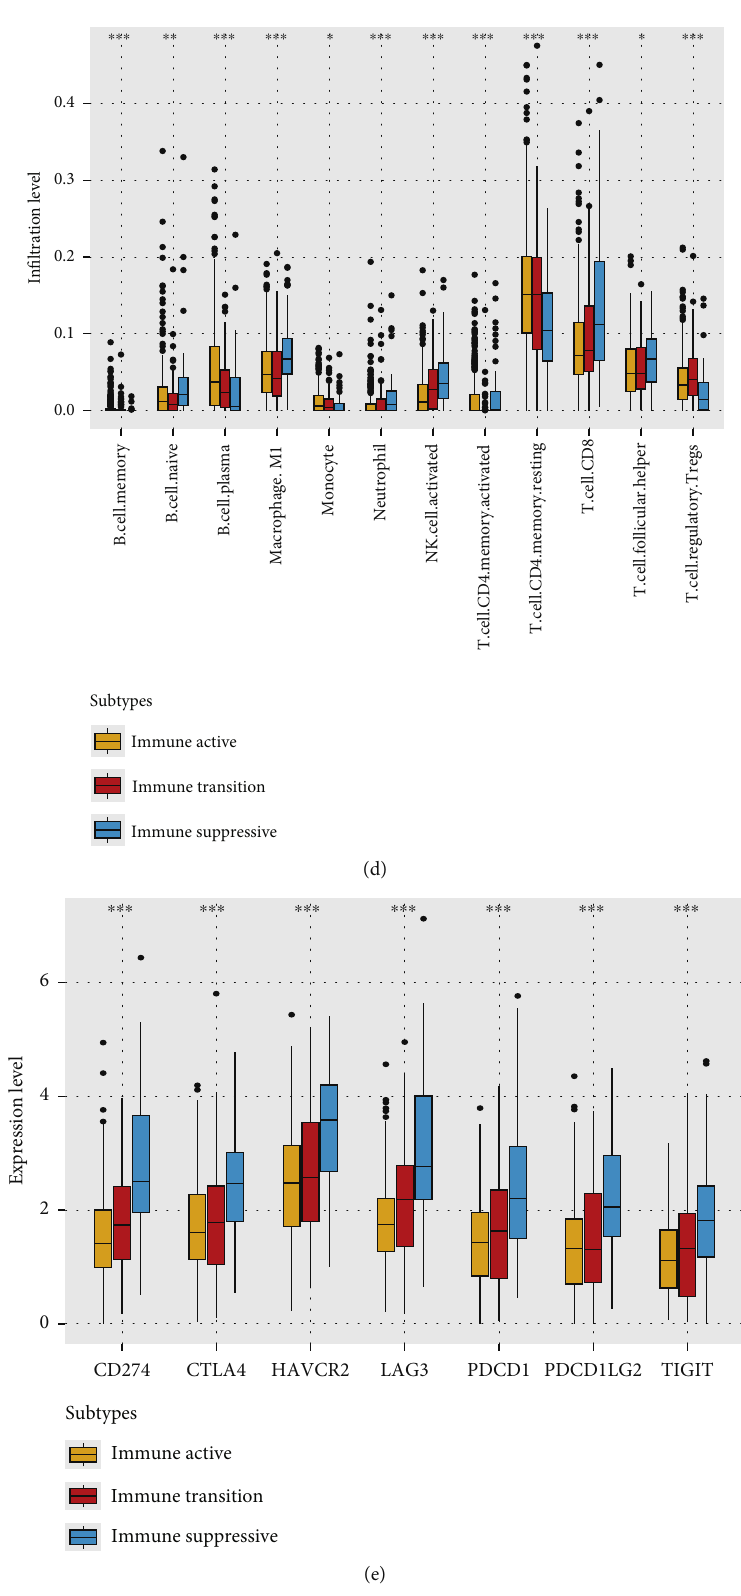
Figure 3: Identi fi cation of the three immune subtypes of CRC: (a, b) identi fi cation of CRC immune subtypes based on consensus clustering analysis; (c) immune landscape of the three CRC immune subtypes; (d) comparison of immune in fi ltration levels among the three immune subtypes; (e) comparison of immune checkpoint expression levels among the three immune